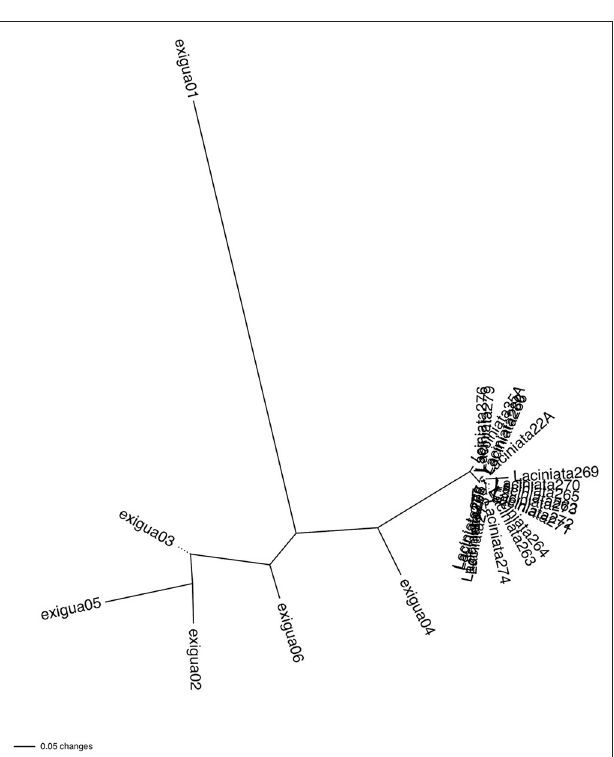
FIGURE 3 | Unrooted neighbor-joining phylogram of Nei’s genetic distance matrix of populations of Leavenworthia exigua , with branch lengths proportional to genetic distance among populations. The phylogram shows that Leavenworthia exigua var. laciniata populations are largely genetically identical or very similar to each other whereas Leavenworthia exigua var. exigua shows longer branch lengths, indicating genetic variation among populations.